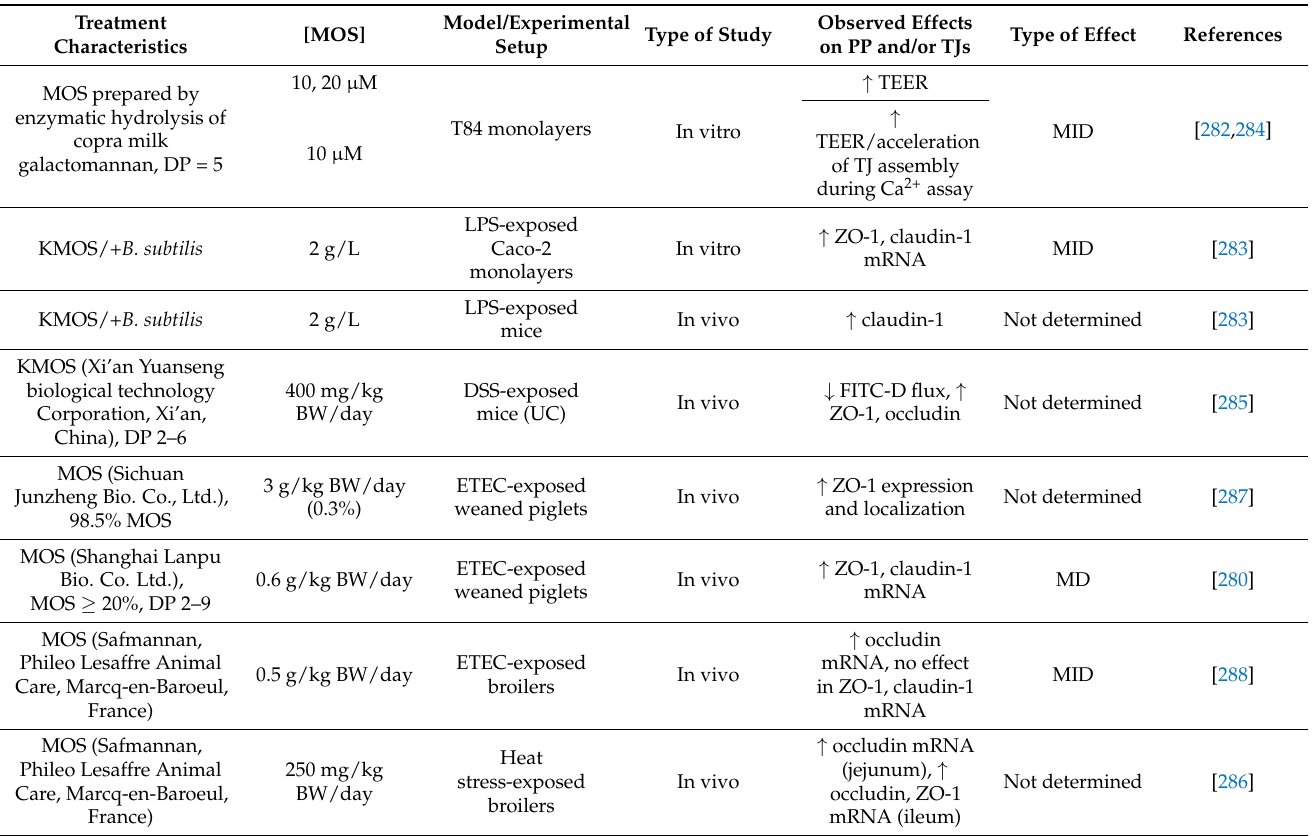
Table 5. Microbiota-dependent and independent effects of MOS on paracellular permeability and/or